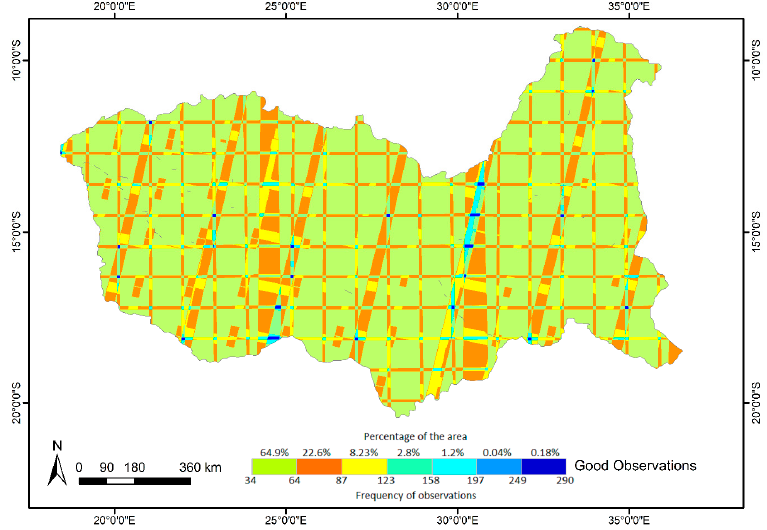
Figure A2. Number of good observations during the rainy season (October 2018 and November– March 2019). The bar legend indicates the frequency of observations of combined Landsat-8 and Sentinel-2 imageries. Table A1. Results of overall accuracy (OA) and kappa Coefficient over the different AEZs based on the applied image classification methods.